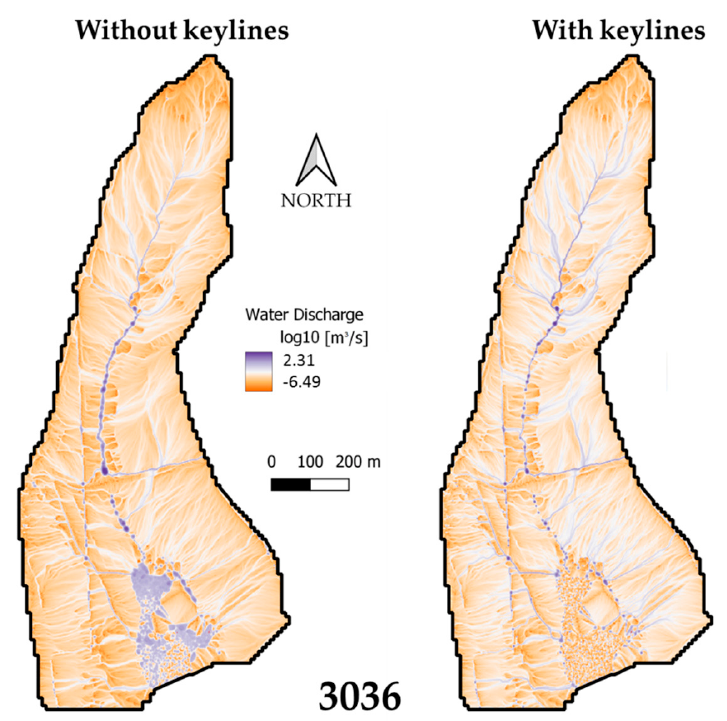
Figure 6. Water discharge (SIMWE) maps with and without the keylines for basin 3036.